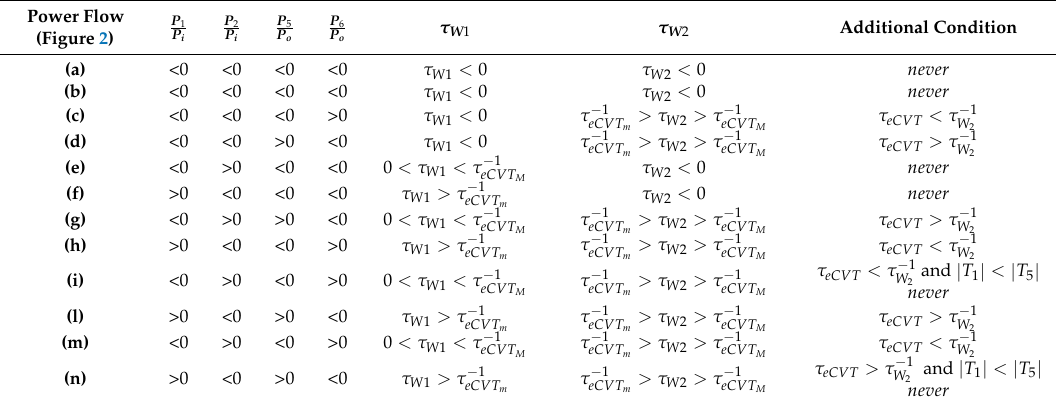
Table 4. Case 2—Conditions of the planetary gear constants for each power flow. The grey rows represent the power flows that cannot occur.